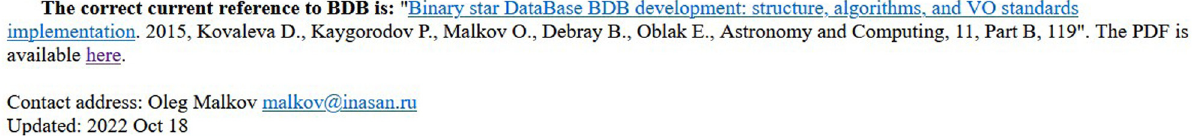
Figure 1: The BDB